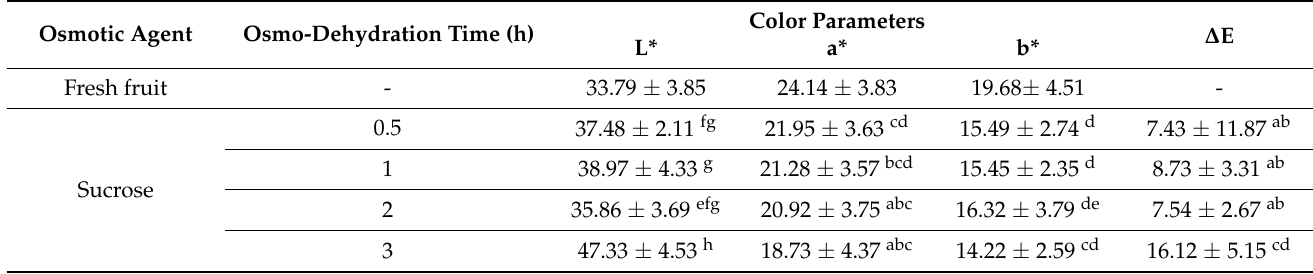
Table 2. Comparison of color parameters and the absolute color difference of osmotic dehydrated